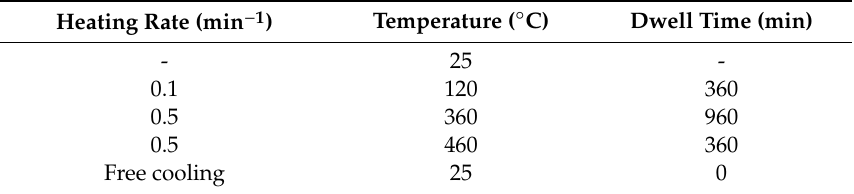
Table 2. Debinding of aluminum nitride specimens shaped via LCM and conventional